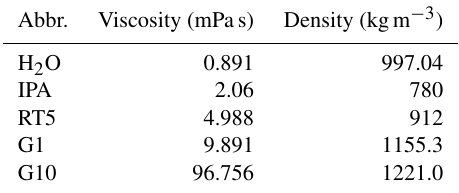
Table 1. List of all liquids used for measurements with shear vis- cosity and density at 25 ◦